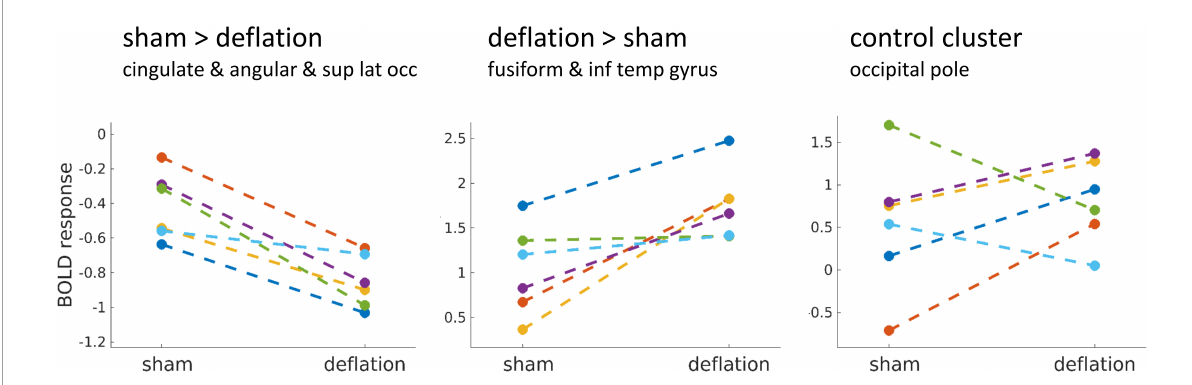
FIGURE2 Mean brain activation in the significant clusters (left, middle) compared to a visual control cluster (right) during food image presentation minus brain activation during the degraded image presentation, for the sham and deflation condition. Each line is one participant. The control cluster was defined as the BOLD response to the degraded images in the sham condition thresholded at T > 10 and included bilateral clusters in the occipital pole (region of foveal vision processing). Sup, superior; lat, lateral; occ, occipital; inf, inferior; temp,